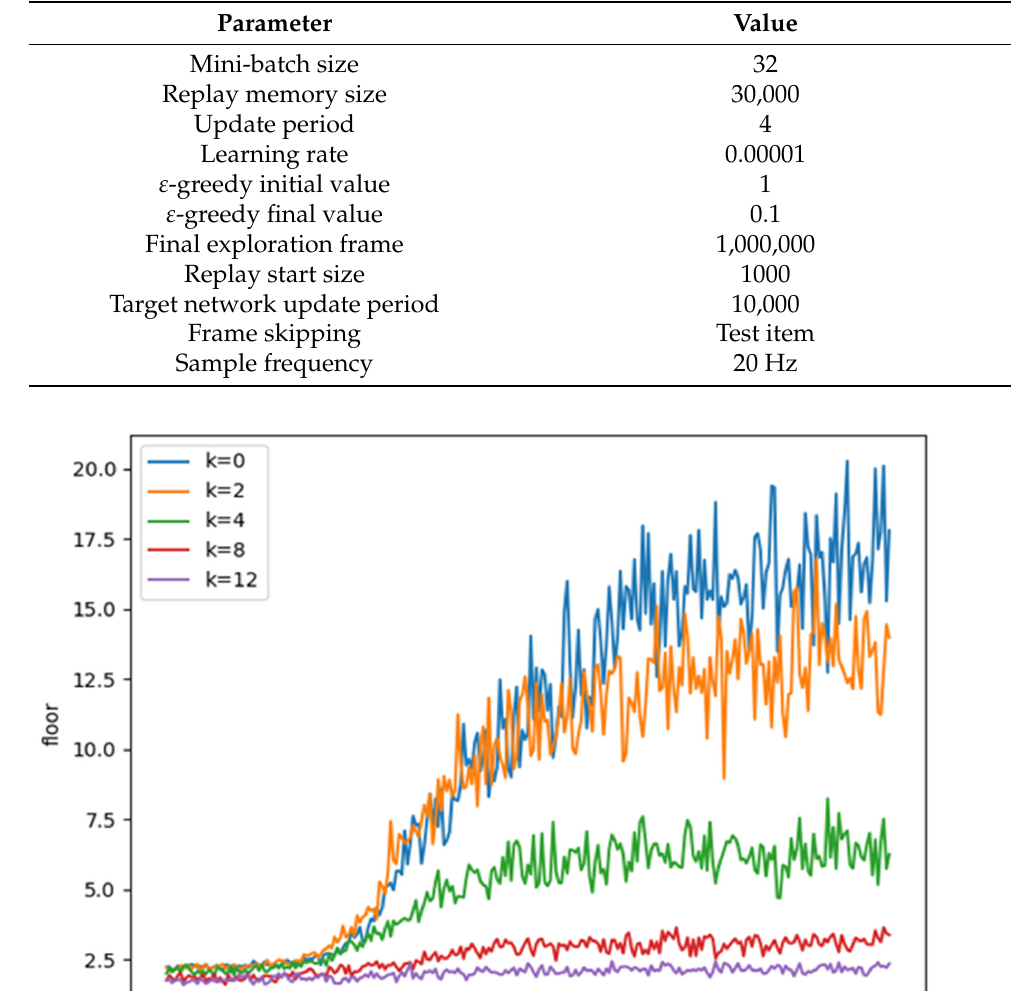
Table 9. The parameters for testing frame skipping.